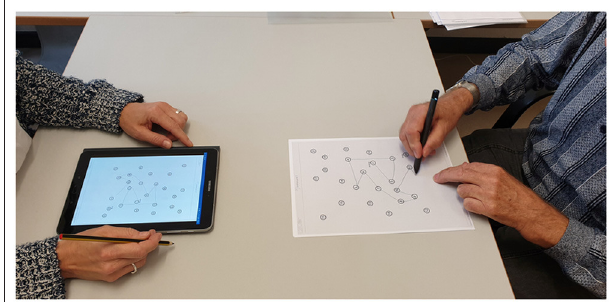
FIGURE 7 | The data collection setup in the geriatrics daycare clinic. The subject (right) performs the cognitive test (here TMT) using a digital pen, which is connected via Bluetooth. The result can be monitored in real-time on the tester’s tablet